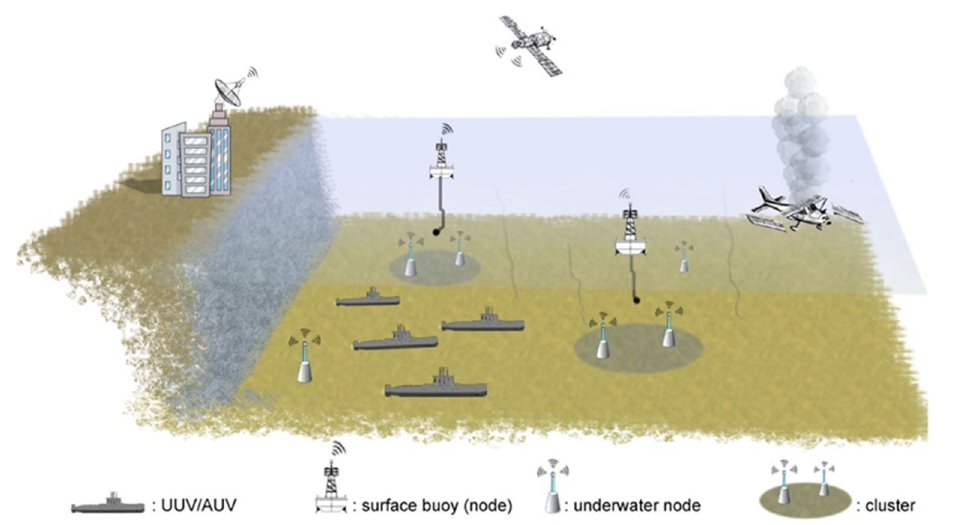
Figure 1. Physical topology of a SAR scenario involving UUVs and other IoUT assets interoperating.